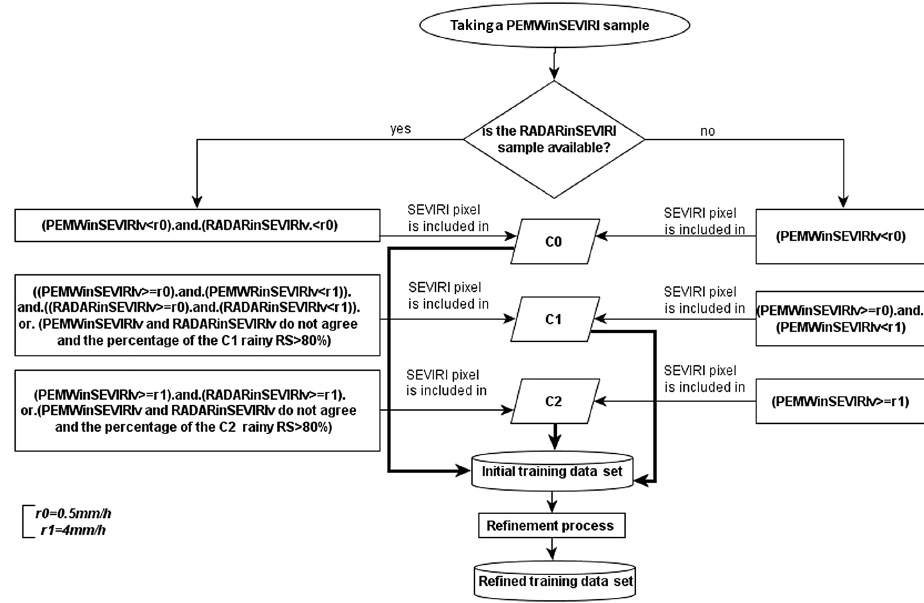
Figure 2. Flowchart of the RainCEIV training